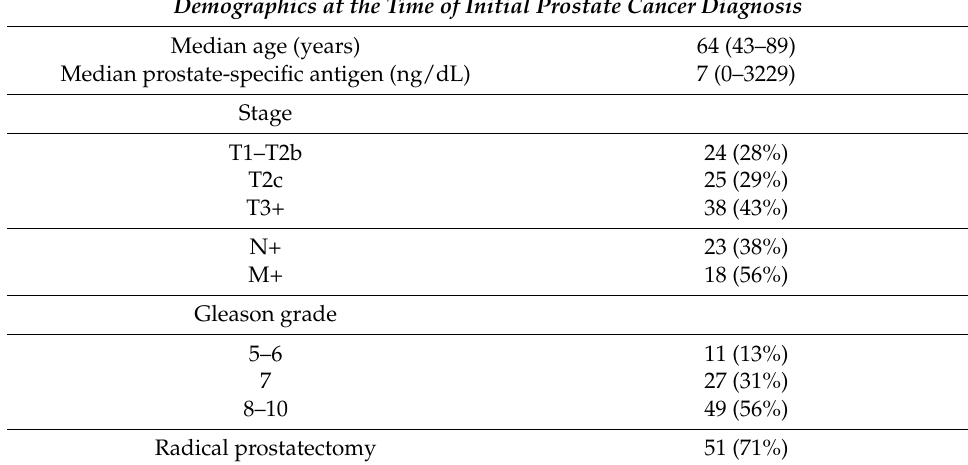
Table 1. Characteristics of 87 patients receiving abiraterone acetate and prednisone for metastatic castration-resistant prostate